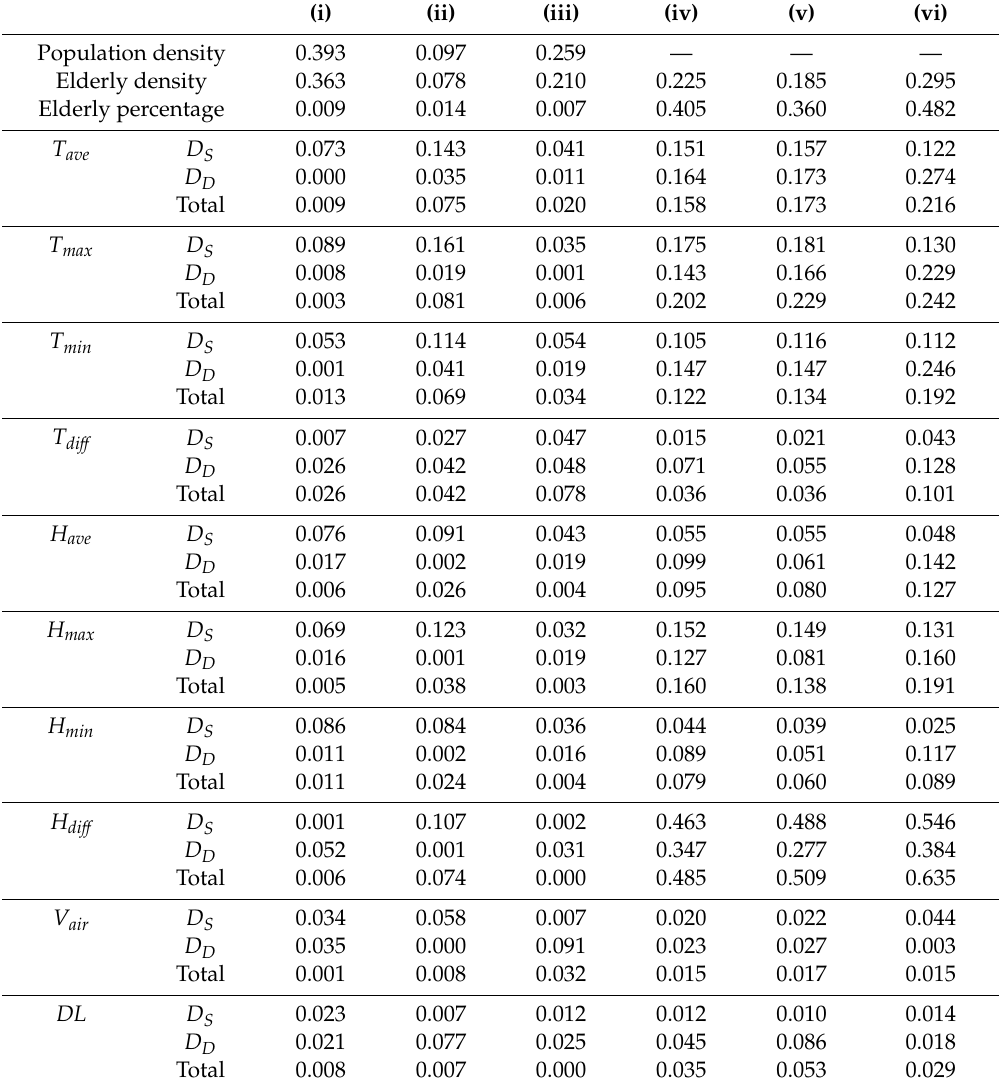
Table 4. Coe ffi cient of determination for di ff erent metrics: (i) cases, (ii) death, (iii) death excluding nosocomial infection, (iv) cases normalized by density, (v) death normalized density, and (vi) death excluding nosocomial infection normalized by population